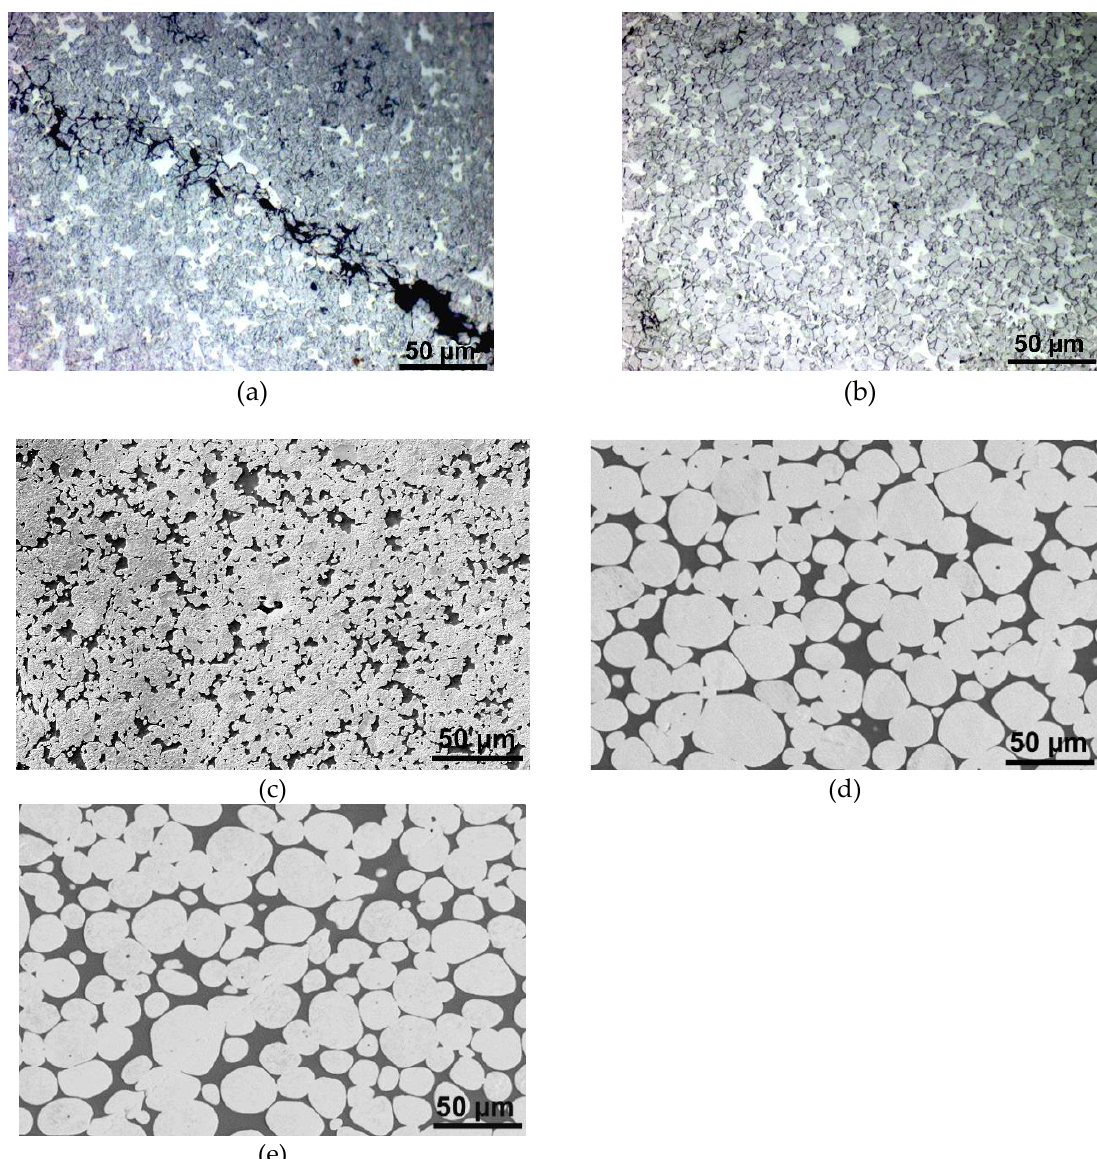
Figure 2. Structure scans of individual sintered pieces: 1450 °C/30 min ( a ); 1475 °C/30 min ( b ); 1500 °C/30 min ( c ); 1525 °C/30 min ( d ); 1550 °C/30 min ( e ). In OM images, white/light areas depict the NiCo matrix, grey areas depict tungsten, and black areas depict voids/cracks.